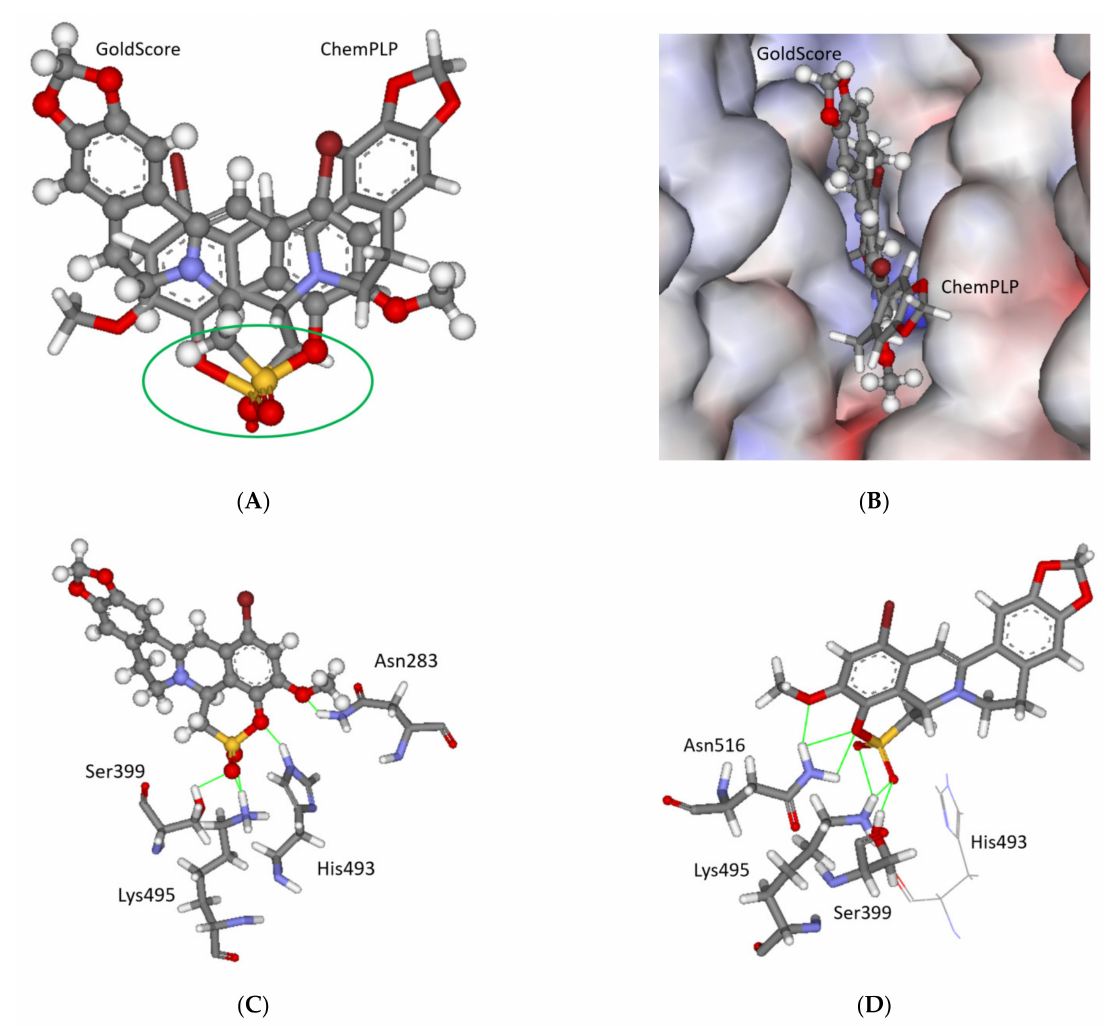
Figure 10. The docked configuration of 18a in the binding site of Tdp1 as predicted by the GoldScore (ball and stick) and ChemPLP (stick) scoring functions. ( A ) The docked overlaid conformations for the GoldScore and ChemPLP predictions. The hydrogen bonding sulfonate moiety is circled in green. ( B ) The protein surface is rendered; blue depicts regions with a partial positive charge on the surface; red depicts regions with a partial negative charge and grey shows neutral areas. The ligand occupies the binding pocket, blocking access to it in both predicted configurations. ( C , D ) Hydrogen bonds are shown as green lines between the ligand ( C ), as predicted by GoldScore with amino acids Asn283, Ser399, His493 and Lys495; ( D ) was predicted by ChemPLP with amino acids Ser399, Lys495 and